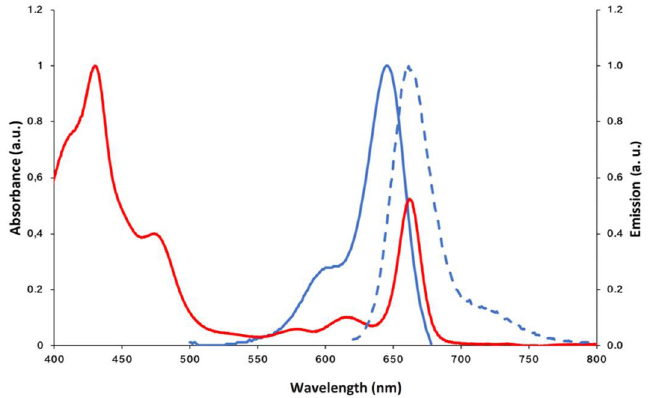
Figure 2. Absorption spectra of Cy5 (blue continuous line) and pigments (red line) extracted from Thalassiosira weissflogii diatoms and emission spectrum of Cy5 (dashed blue line) in